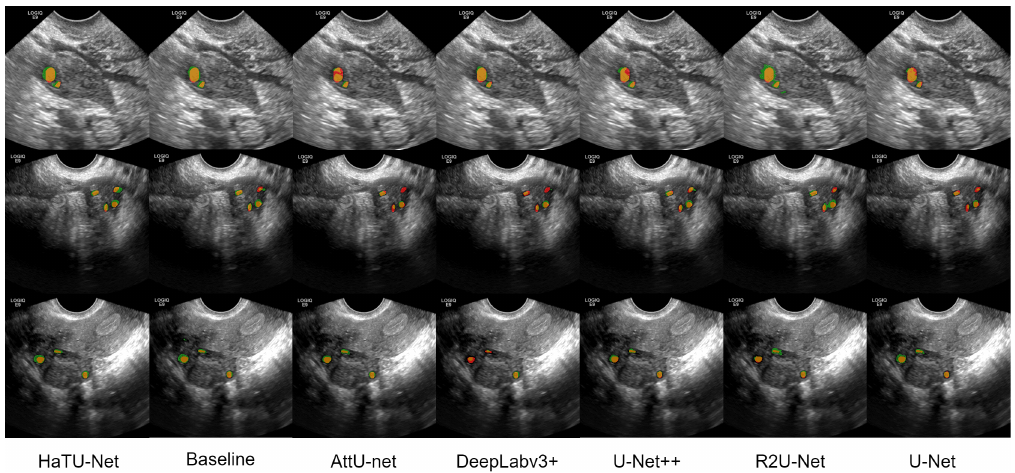
Figure 8. Illustration of three qualitative example results generated by HaTU-Net against five state-of-the-art methods for follicle